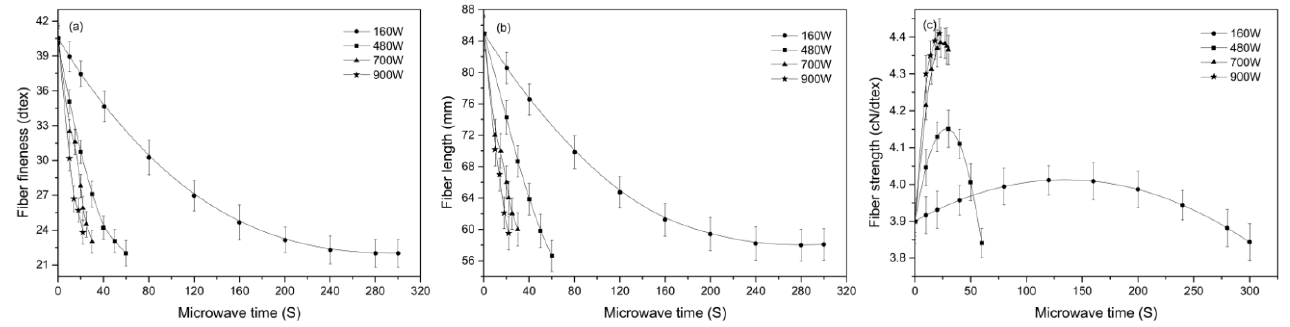
Figure 3. Effect of microwave power and time on the ( a ) fineness, ( b ) length and ( c ) tensile strength at break of the cotton stalk fibers.